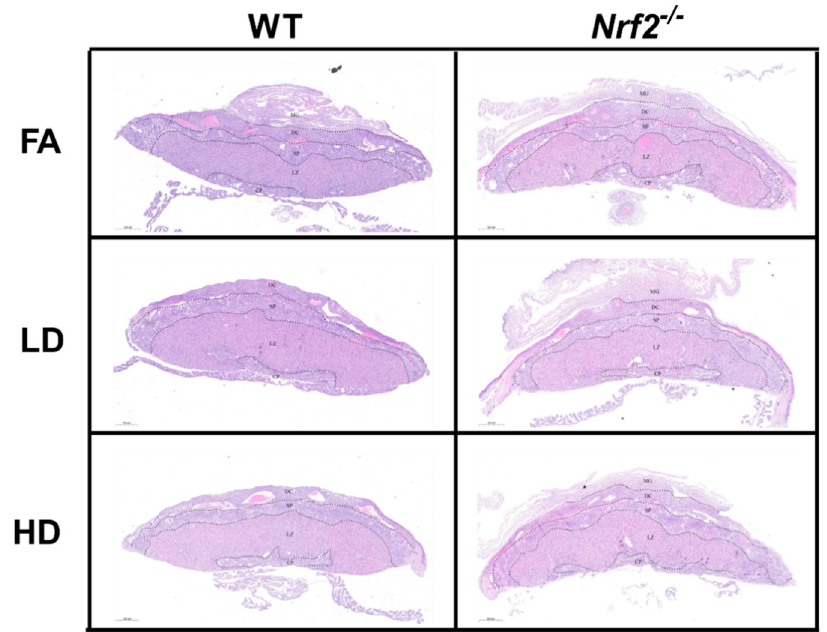
Figure 2. Placental Histology. Representative placental images collected from male offspring depict- ing wildtype (WT) and Nrf2 − / − mice exposed to filtered air (FA) control, low dose (LD; 100 µg/m 3 ), and high dose (HD; 500 µg/m 3 ). No gross histologic changes were observed across the different groups. Area measurements were made for decidua (DC), spongiotrophoblast (SP), and labyrinth zone (LZ) layers. Sample sizes for placenta from male offspring: WT FA ( n = 7), WT LD ( n = 11), WT HD ( n = 13), Nrf2 − / − FA ( n = 10), Nrf2 − / − LD ( n = 9), Nrf2 − / − HD ( n = 8).